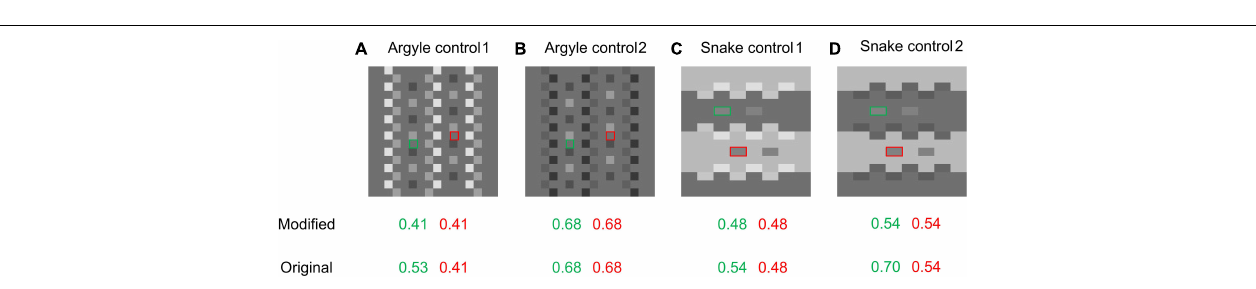
FIGURE 9 | Variants of the White-effect figure and the modified model’s outputs for them. (A) Anderson et al. (2001)’s variant. The model does not predict an illusion for it. (B) Todorovi´c (1997)’s variant. Although the model predicts an illusion for the case shown in this figure, it is highly unstable. (C) Clifford and Spehar (2003)’s variant. The modified model does not predict an illusion.